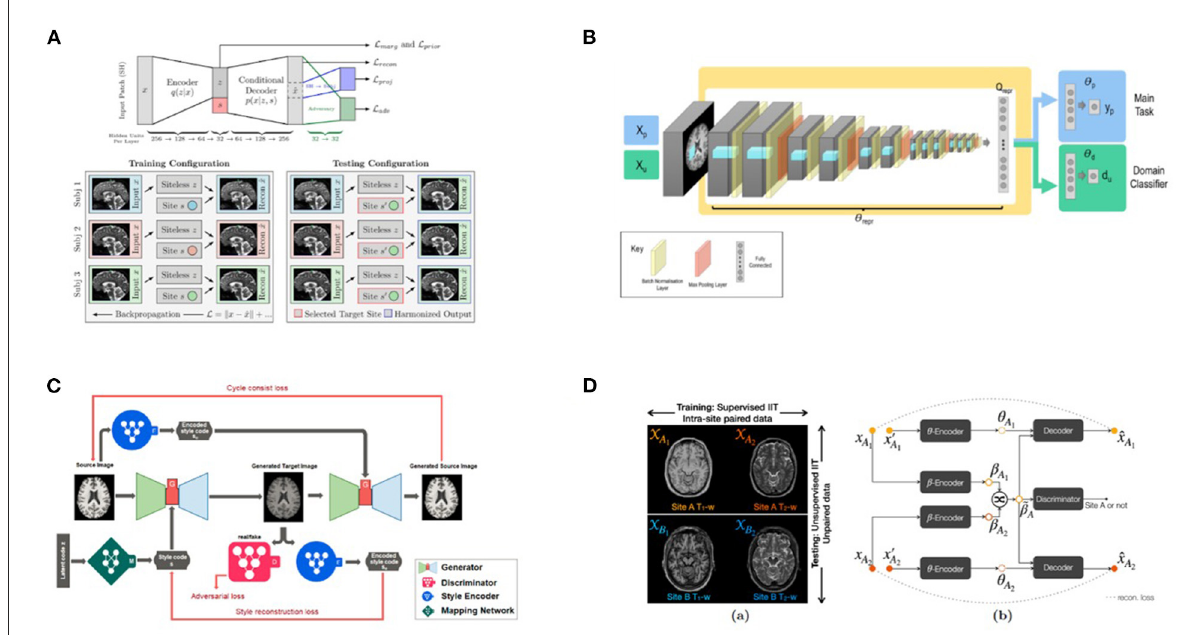
FIGURE4 Four GAN-based deep learning harmonization models. (A) The network architecture in Moyer et al. (41). The invariant representations to and from the images are learned using an encoder/decoder architecture, with a one-hot vector to represent the protocol identifiers. (B) General network architecture in (67). The network is formed of three sections: the feature extractor with parameters, the label predictor with parameters, and the domain classifier with parameters. The domain invariant features (from the feature extractor), which are used in domain-invariant label predictions. are learned by confusing the domain classifier. The represents the input data used to train the main task with labels, and represents the input data used to train the steps involved in unlearning scanner with labels d. (C) The architecture of the style-encoding GAN (44). Generators learn to generate images by inputting a source image and a style code. The anatomy of the brain MRI was preserved using a cycle-GAN architecture, and the harmonization was achieved by inserting a style code into the images. Reproduced with permission. (D) (a) Given T1-w and T2-w images from Sites A and B, the method from Zuo et al. (69) learns the site-invariant anatomy from supervised image-to-image translation (T1–T2 synthesis) and site-variant contrast from unsupervised image-to-image translation (harmonization), where is learned to control the image contrast after harmonization, and is learned to preserve the anatomical